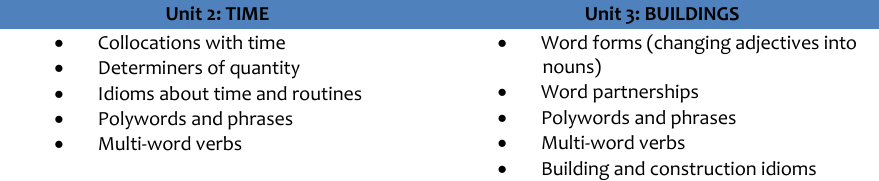
Table 4. Five Lexical Chunks Implemented in Units 2 and 3 Unit 2: